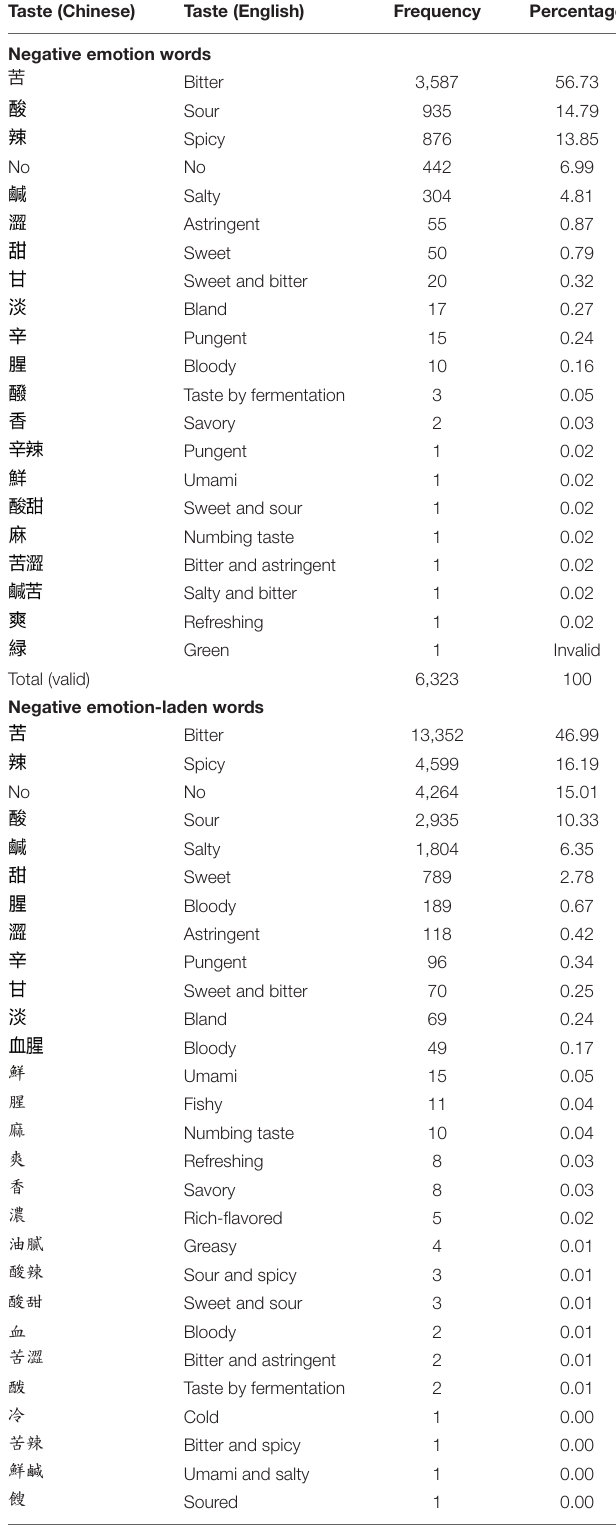
TABLE 1 | Summary of taste responses and their frequency and percentage for four kinds of emotional